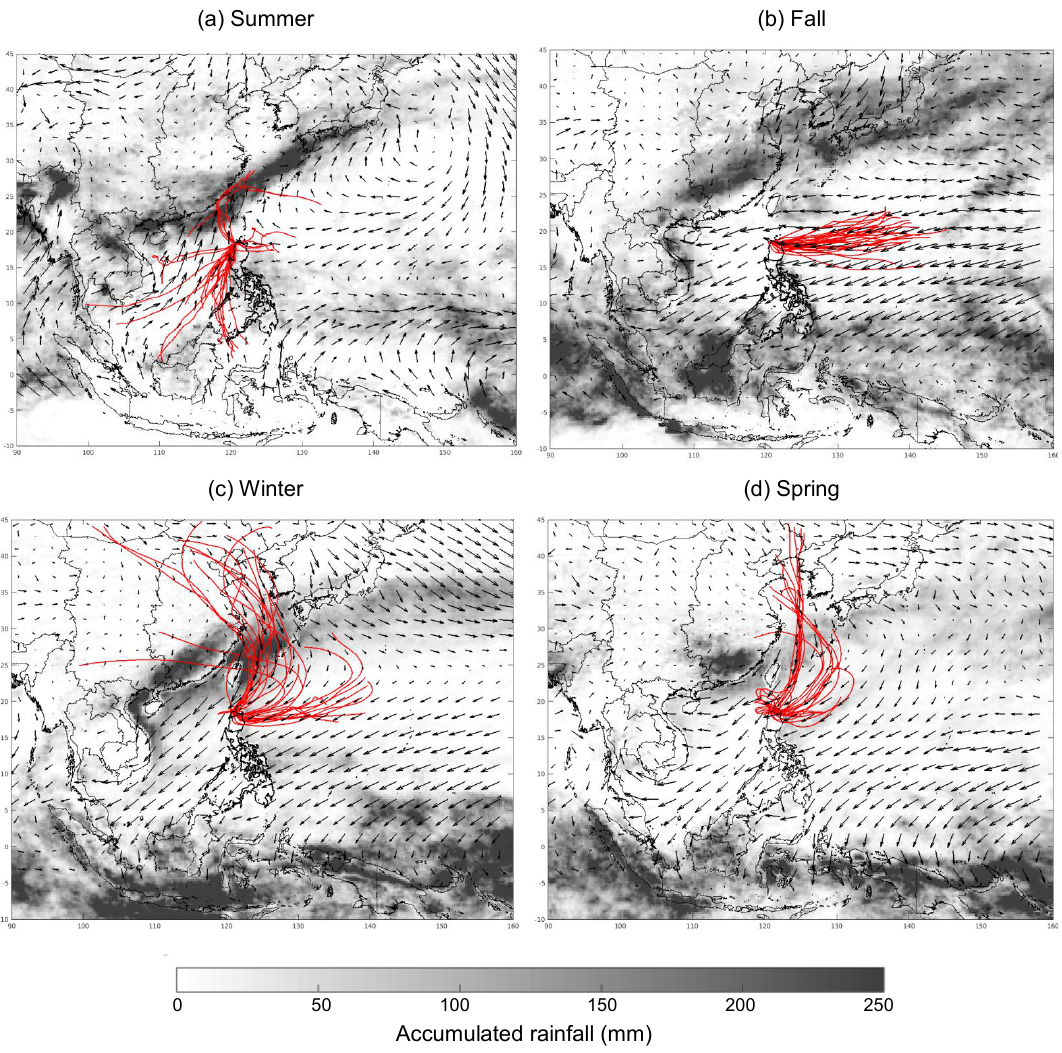
Figure 2. Wind (arrows), accumulated rainfall for each sampling period (shading, in millimeters) and wind back trajectory (red line) during (a) summer, (b) fall, (c) winter and (d) spring sampling season. The grayscale shows white for a value of 0 and black for a value of 250 in increments of